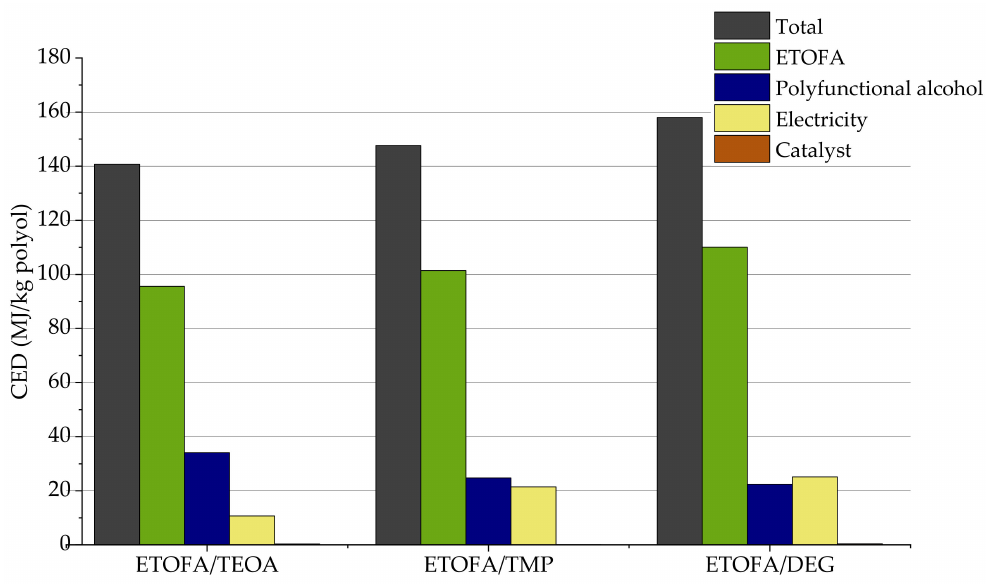
Figure 3. CED results for TOFA-based bio-polyols from the perspective of their production